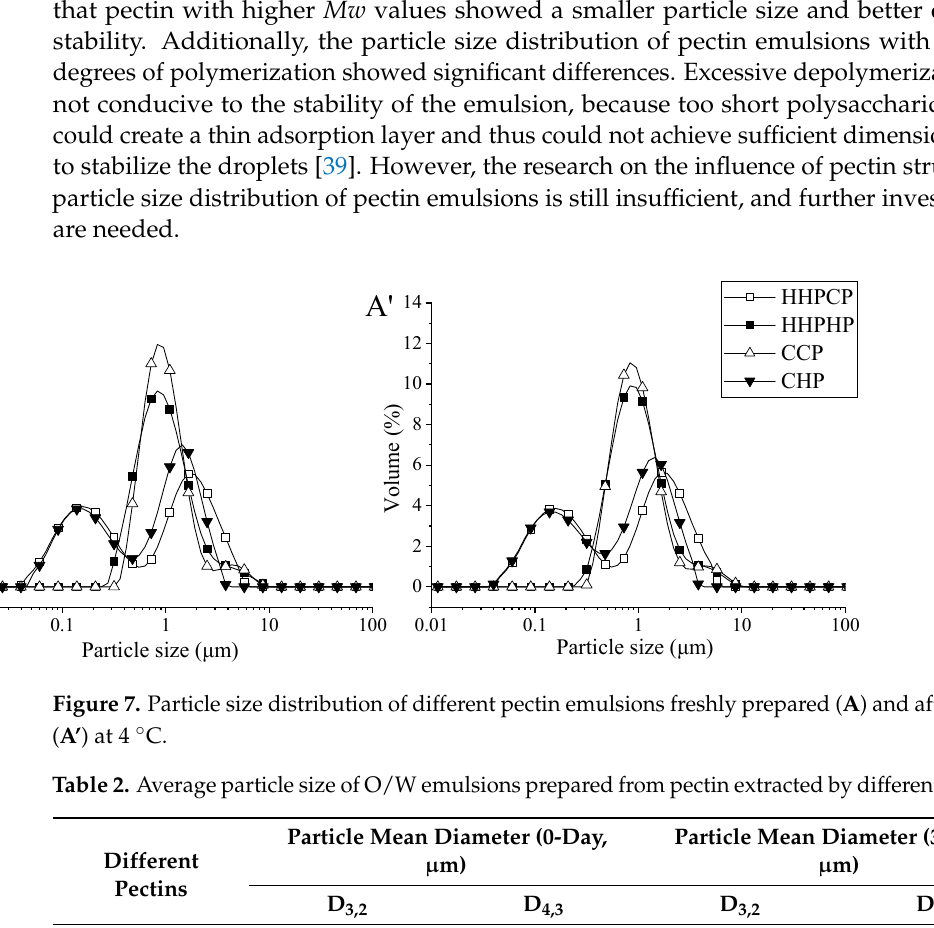
Table 2. Average particle size of O/W emulsions prepared from pectin extracted by different meth- ods.